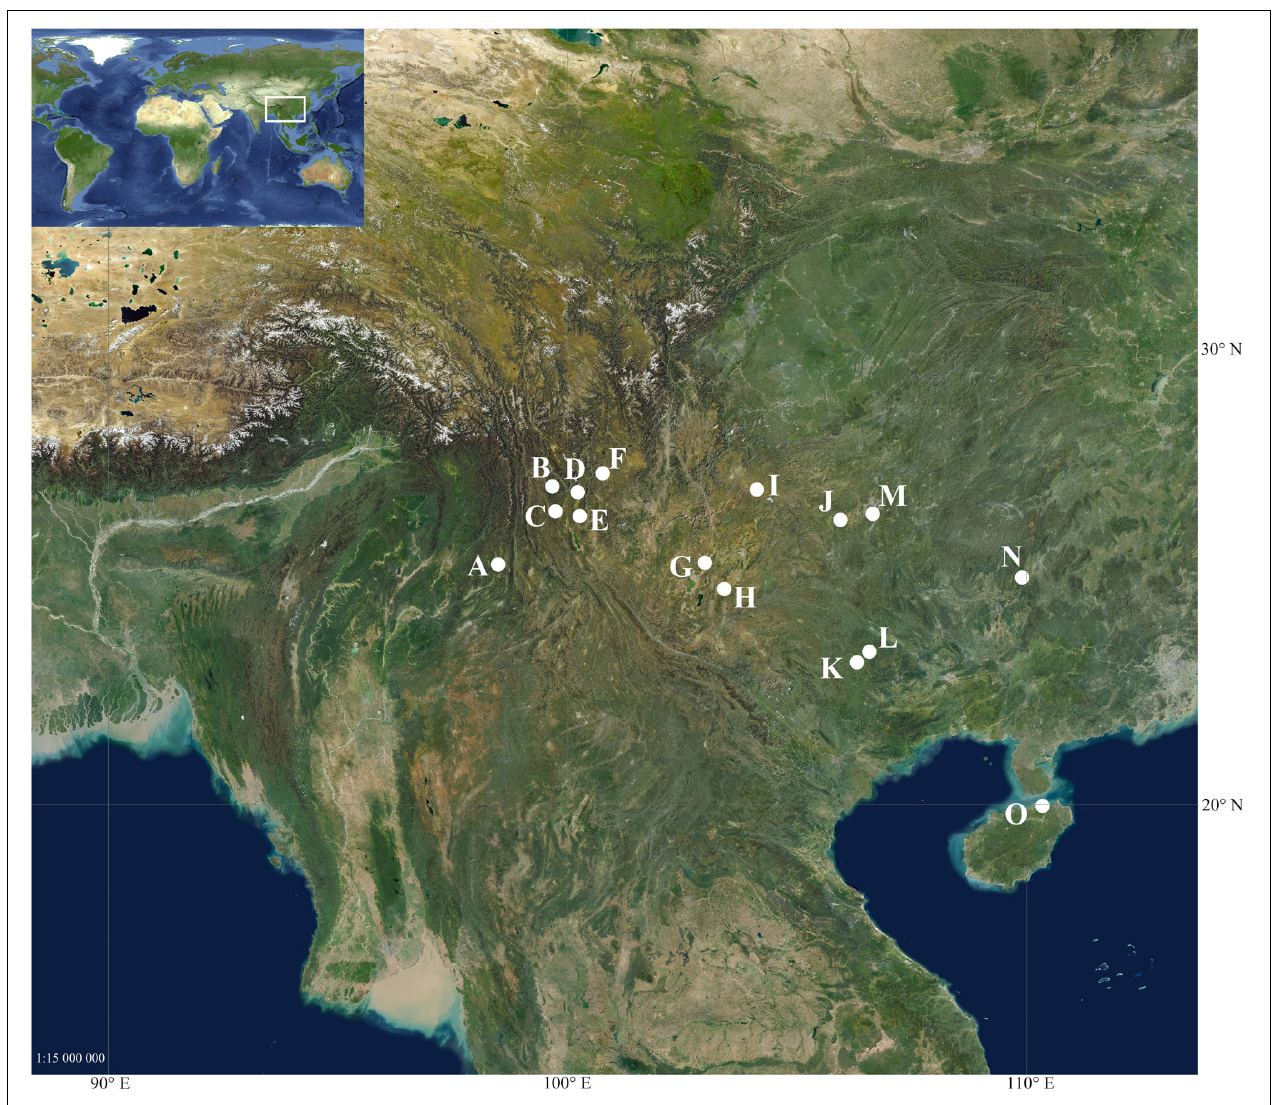
FIGURE 1 | Geographic distribution of sampled populations. (A) Beihai Lake, Tengchong, Yunnan, China (25.276 ◦ N, 98.494 ◦ E); (B) Qixian Lake, Yulong, Yunnan China (26.979 ◦ N, 99.671 ◦ E); (C) Jian Lake, Jianchuan, Yunnan, China (26.436 ◦ N, 99.743 ◦ E); (D) O. Lashihai Lake, Lijiang, Yunnan, China (26.855 ◦ N, 100.226 ◦ E); (E) Heilongtan, Heqing, Yunnan, China (26.334 ◦ N, 100.270 ◦ E); (F) Lugu Lake, Ninglang, Yunnan, China (27.263 ◦ N, 100.770 ◦ E); (G) Heilongtan, Songming, Yunnan, China (25.314 ◦ N, 102.998 ◦ E); (H) Changhu Lake, Shilin, Yunnan, China (24.744 ◦ N, 103.417 ◦ E); (I) Caohai Lake, Weining, Guizhou, China (26.910 ◦ N, 104.129 ◦ E); (J) Anshun, Guizhou, China (26.253 ◦ N, 105.948 ◦ E); (K) Equan River, Jingxi, Guangxi; China (23.146 ◦ N, 106.311 ◦ E); (L) Longtan River, Debao, Guangxi, China (23.379 ◦ N, 106.583 ◦ E); (M) Huaxi, Guiyang, Guizhou, China (26.384 ◦ N, 106.654 ◦ E); (N) Baishou River, Yongfu, Guangxi, China (24.993 ◦ N, 109.907 ◦ E); (O) Haikou, Hainan, China (20.018 ◦ N, 110.349 ◦ E).